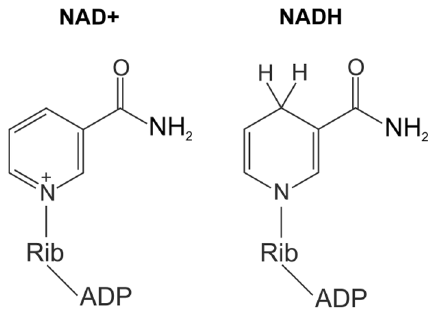
Figure 1. Structures of NAD+ and NADH.